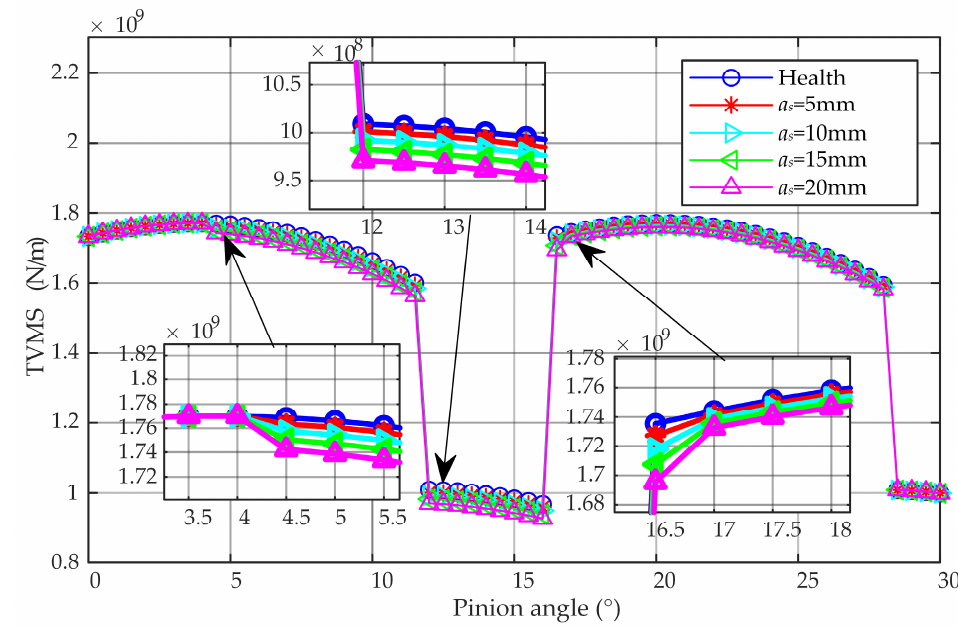
Figure 4. Comparison of TVMS of gears with different spalling lengths under fixed width and depths.